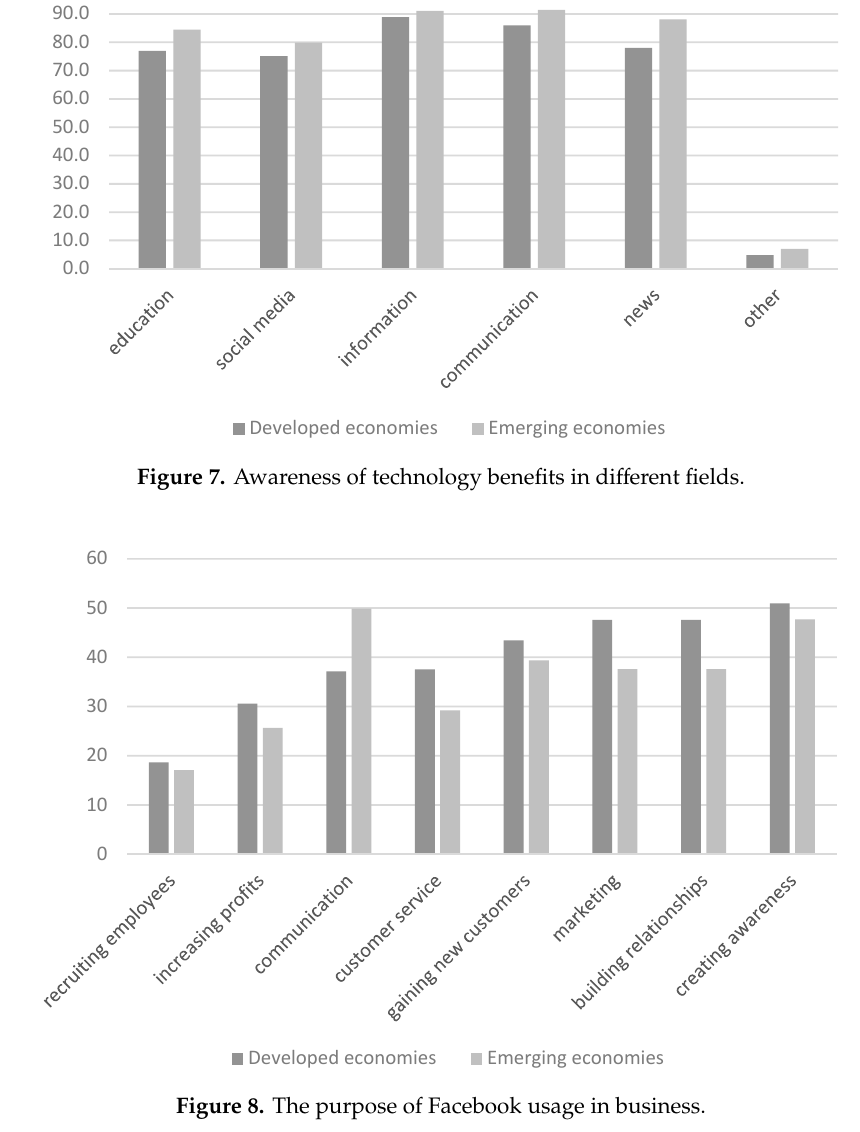
Figure 8. The purpose of Facebook usage in business. Information 2020 , 11 , x FOR PEER REVIEW